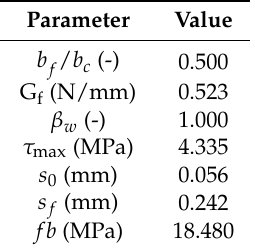
Table 3. Bond law parameters.